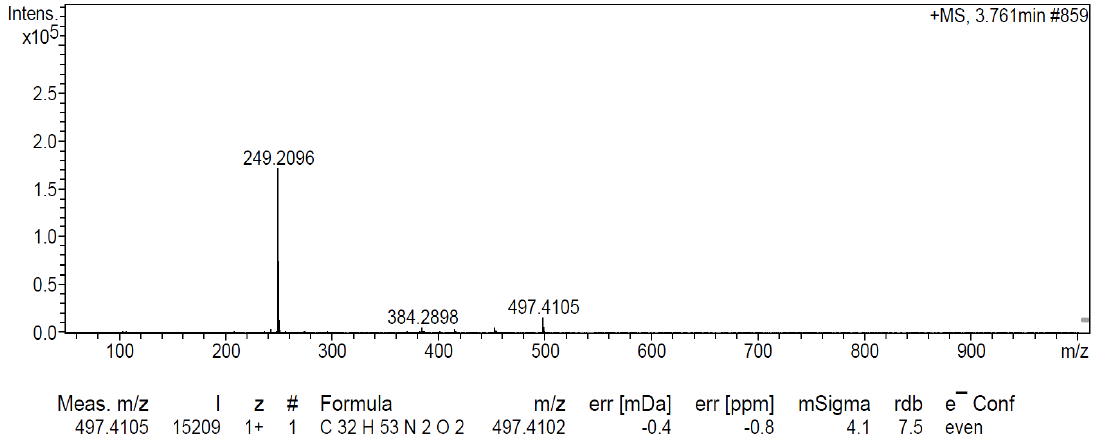
Figure A1. +ESI-QTOF mass spectrum of compound 1 .